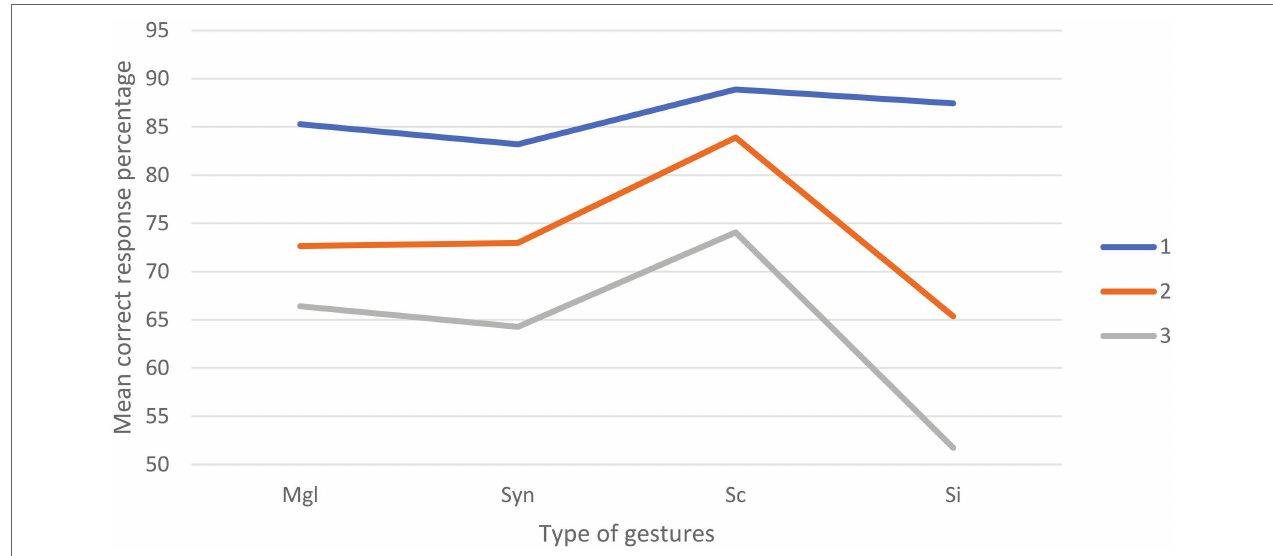
FIGURE 4 | Graphical representation of the percentage of correct answer according to the types of gestures presented and the level of hearing alteration (Mgl = Meaningless; Syn = syntactically incongruent; Sc = semantically congruent; SI = semantically incongruent; 1 = clear speech; 2 = 50% degradation; 3 = 100% degradation).